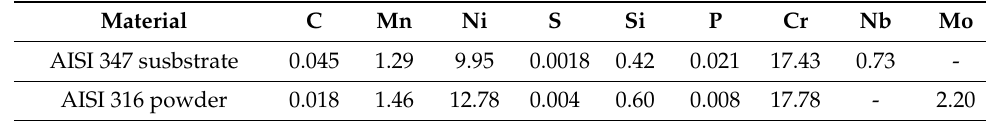
Table 1. Chemical composition (weight %) of the substrate and